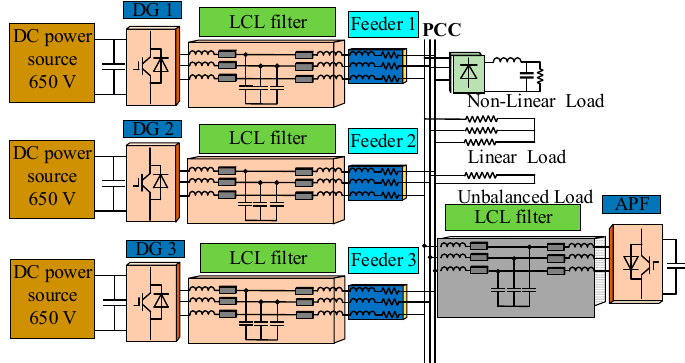
Figure 1. Diagram of the simulated test setup with three inverters and one active power filter (APF). DG = distributed generators; PCC = point of common coupling; LCL filter = inductive-capacitive-inductive filter; DC power source = direct current power source.